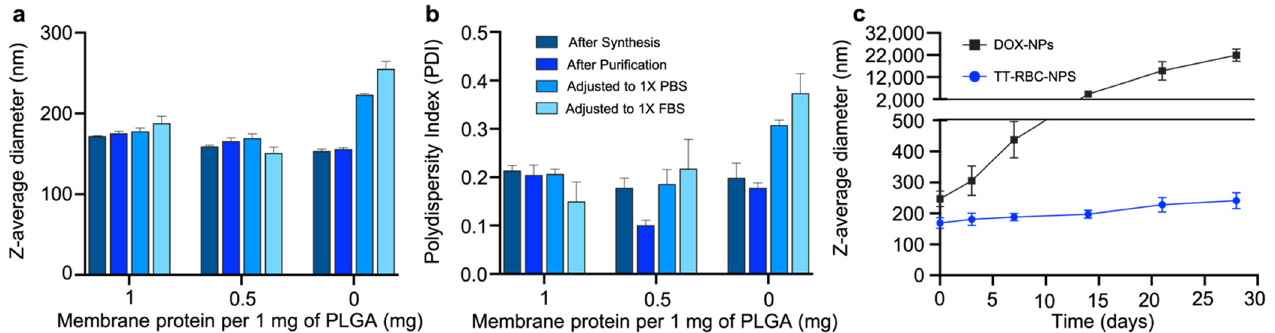
Figure 3. Optimization and stability of TT-RBC-NPs. ( a ) Z-average size and b ) Polydispersity index (PDI) as measured by dynamic light scattering (DLS) at varying RBC membrane protein to PLGA weight ratios of doxorubicin-loaded NPs immediately after synthesis, after purification, after adjusting to 1× PBS, and after adjusting to 1× FBS. ( c ) Stability of TT-RBC NPs made at a membrane to core ratio of 0.5 mg protein per 1 mg PLGA versus DOX-NPs over time. Data given as mean ± SD ( n = 3).